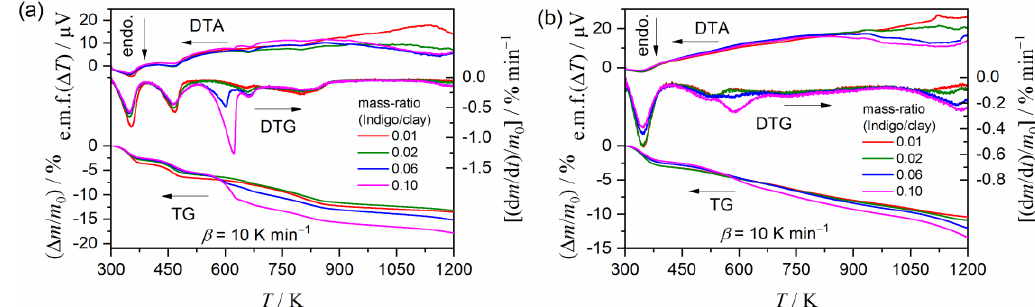
Figure 2. TG–DTG–DTA curves for the heat-treated indigo/clay mineral mixtures synthesized using different initial ratios: ( a ) Indigo/palygorskite and ( b ) indigo/sepiolite.